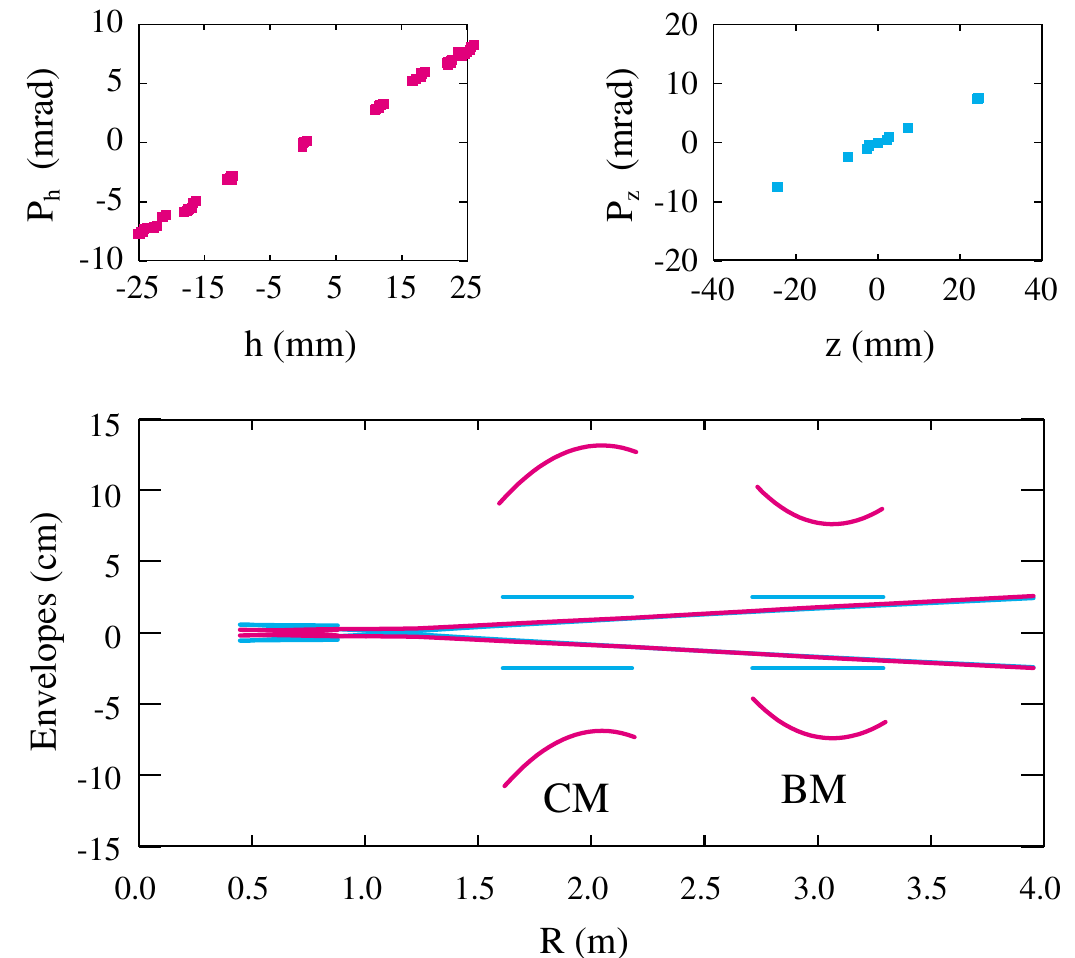
FIG. 10. (Color) Beam emittances and envelopes for K (cid:4) 3 . The structure of the figure is the same as that of Fig. 7. The results correspond to the Ne 9 (cid:3) ion beam obtained after the interaction with the foil of the Ne 3 (cid:3) ion beam previously accelerated to the energy of 3.1 MeV per nucleon. The corresponding parameters of the beam-guiding elements are B (cid:4) (cid:2) 0 : 228 78 T . The horizontal size of the beam slightly exceeds the transport line acceptance; however, the adjustment of and B BM the horizontal width of the beam will enlarge the beam width in all of the remaining three emittance coordinates, namely, P and P z